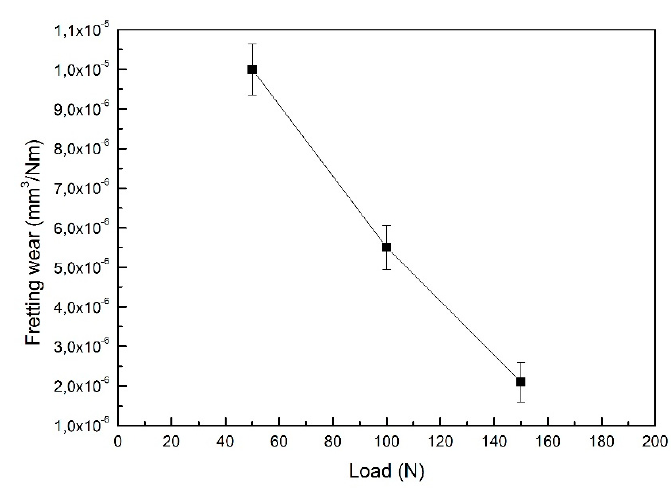
Figure 12. Fretting wear as a function of the applied load.